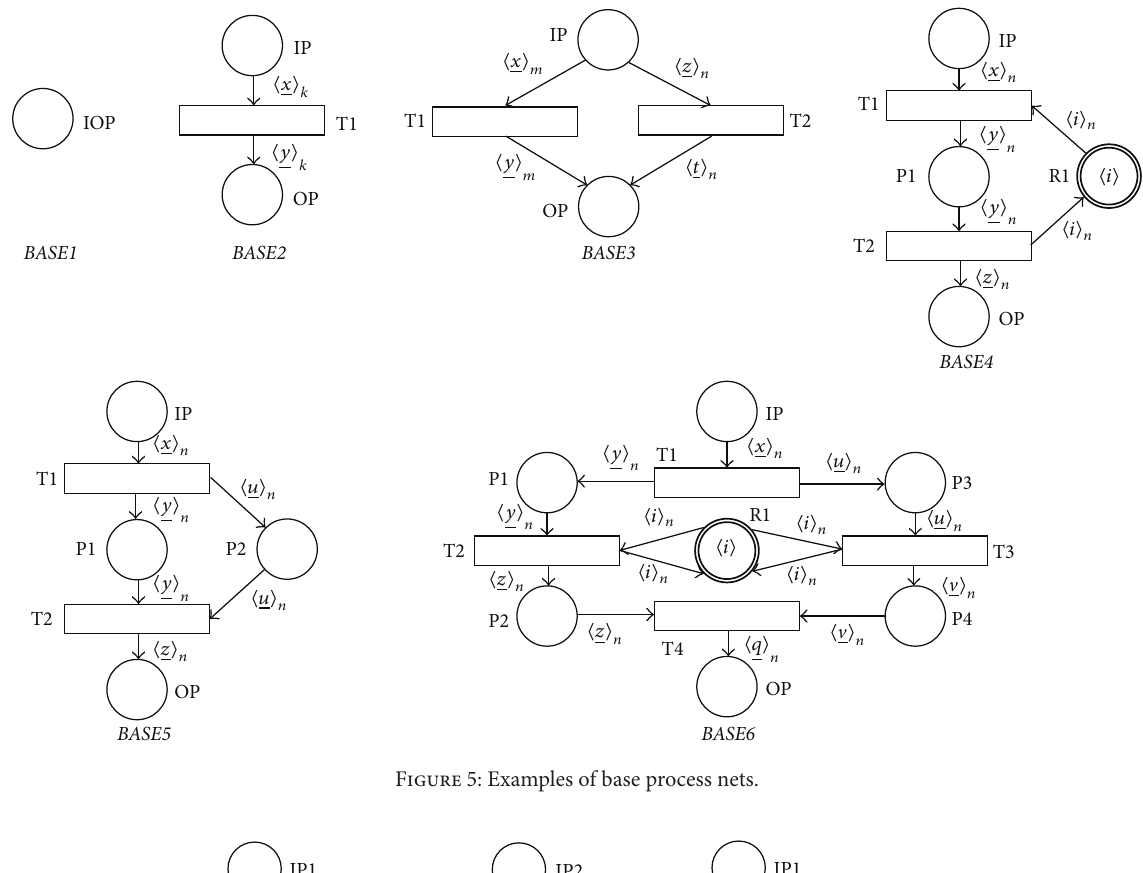
Figure 5: Examples of base process nets.